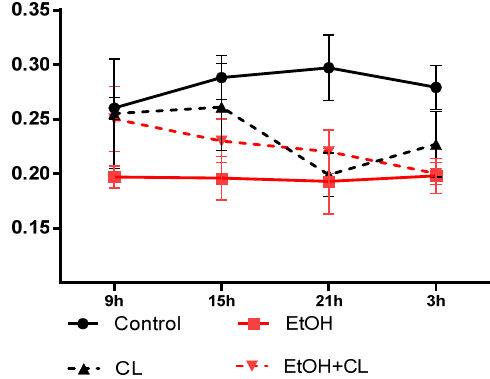
Figure 15. Daily dynamics of NCR of hepatocytes of rats. Table 2. Results of the cosinor analysis of the daily dynamics of the micromorphometric parameters of hepatocytes of rats.